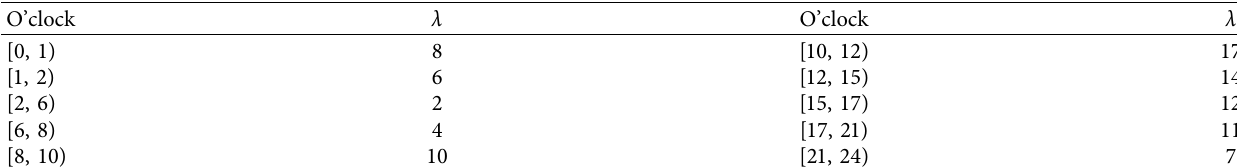
Table 9: Distribution of the number of user arrivals per hour.